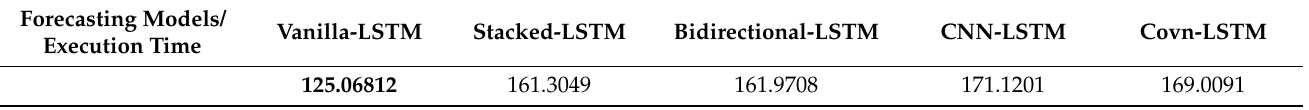
Table 12. Average computational time taken (in seconds) for variants of LSTM forecasting